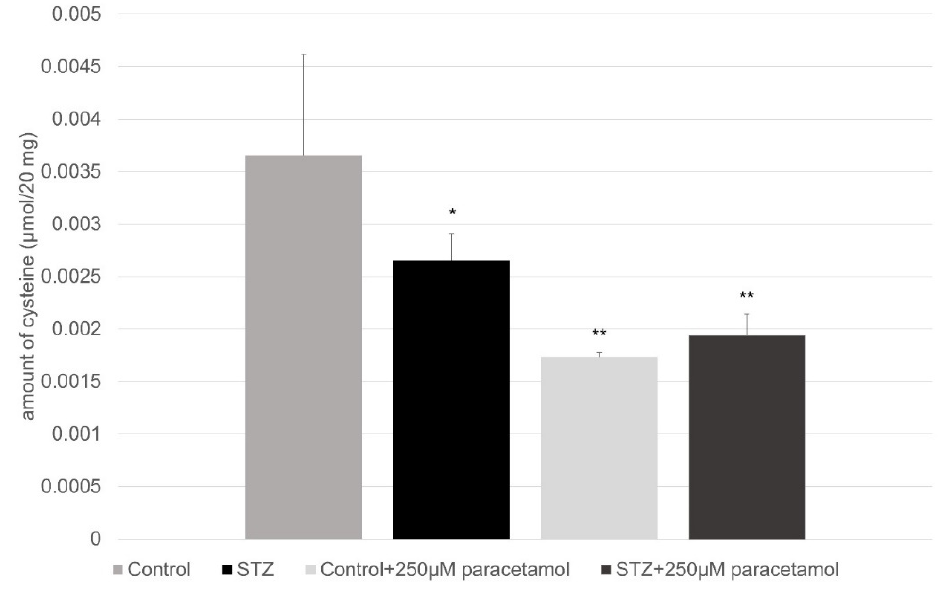
Figure 4. Amount of cysteine ( μ mol/20 mg) in the small intestine without and with paracetamol perfusion in case of control and diabetic rats. Values represent the mean ± S.E. of five rats. Each value represents the mean of 5 independent experiments ± standard error. *, p < 0.05; **, p < 0.01 versus control.